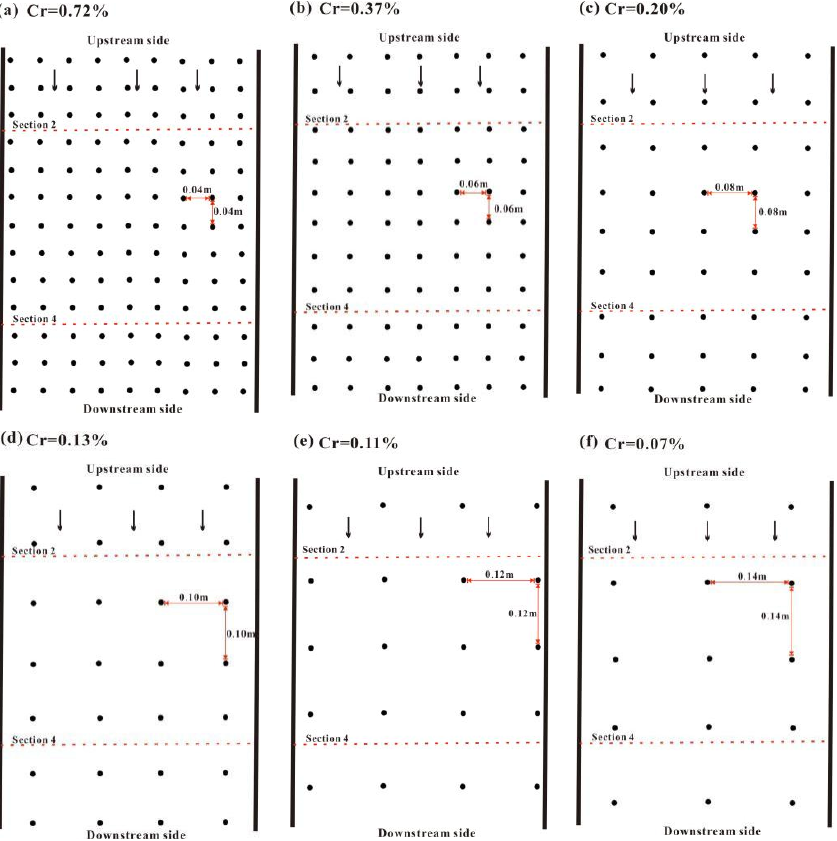
Figure 2. Vegetation distribution under different coverage densities ( a ) Cr = 0.72%, ( b ) Cr = 0.37%, ( c ) Cr = 0.20%, ( d ) Cr = 0.13%, ( e ) Cr = 0.11%, ( f ) Cr = 0.07%.